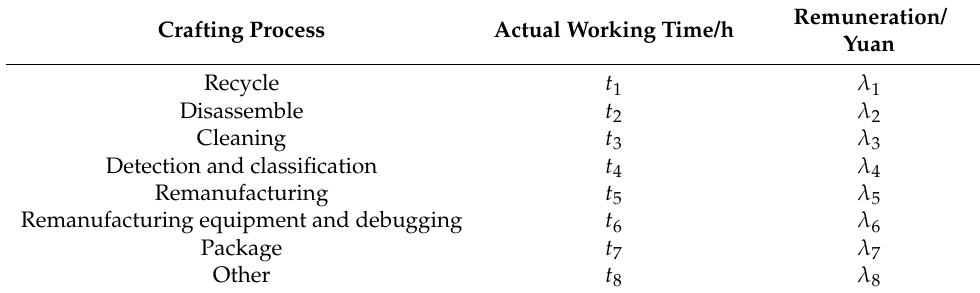
Table 2. Working hours and remuneration table. Crafting